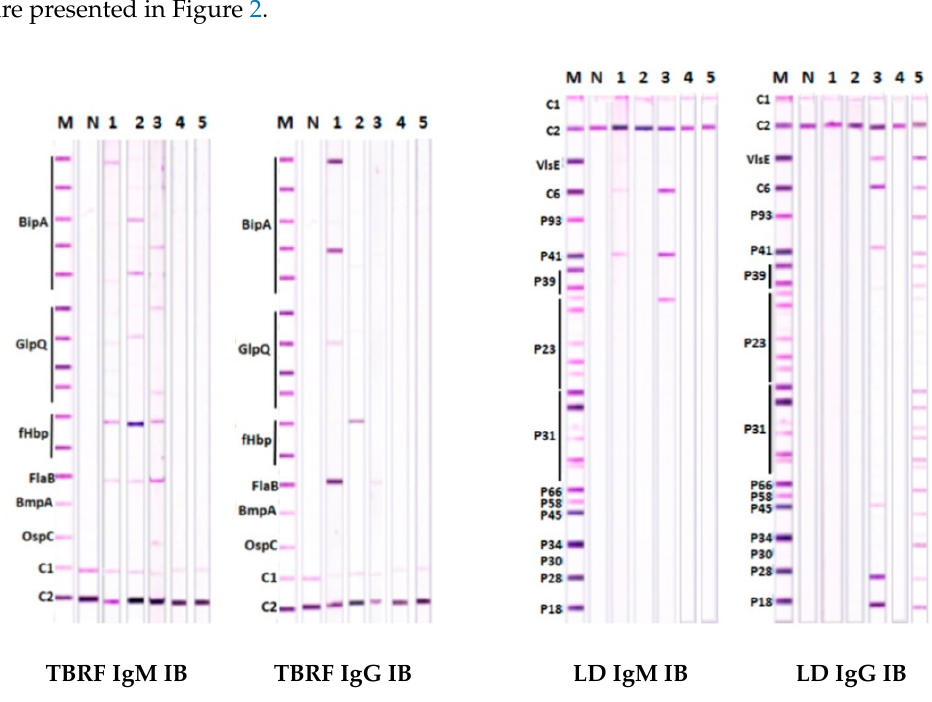
Figure 2. TBRF and LD IgM and IgG immunoblots with representative patient sera. Results obtained with sera from five patients in IgM and IgG IBs for TBRF and LD, where antibody reactivity was